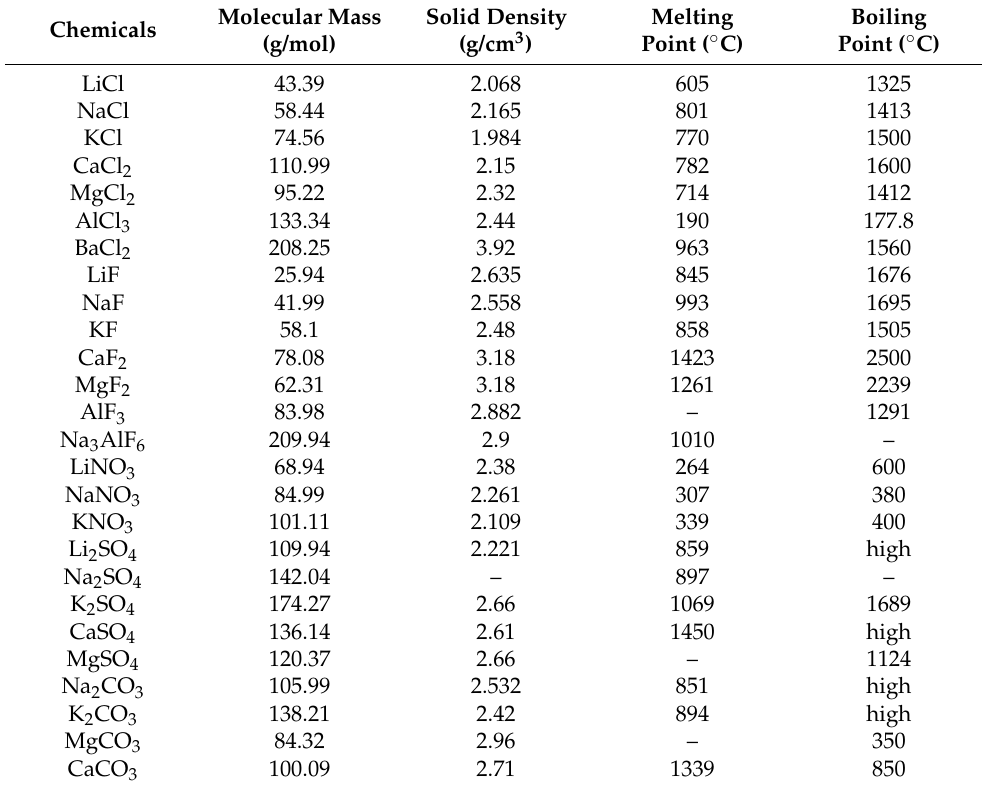
Table 1. Thermophysical parameters of salt compounds used in fluxes.